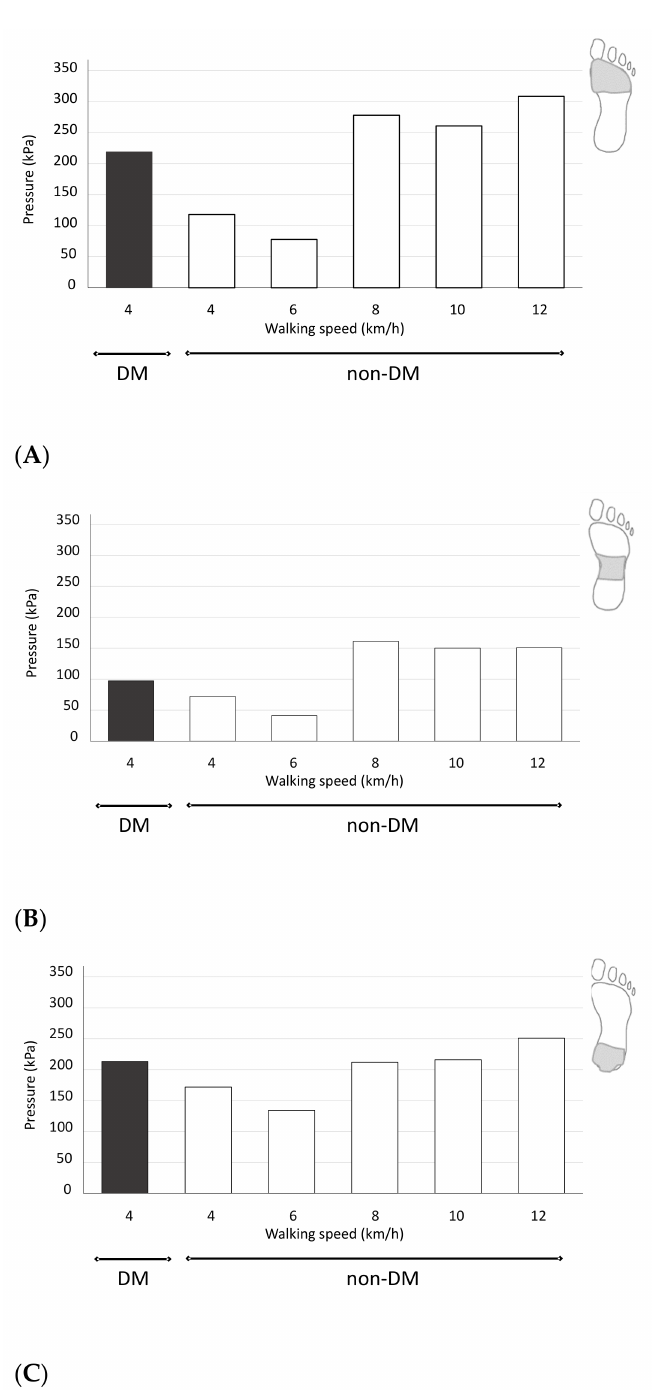
Figure 3. The PPP at three regions ( A ) forefoot, ( B ) midfoot, and ( C ) rearfoot. The speed was categorized as preferred walking speed in people with DM (4 km/h) and five different speeds in non-DM people (4, 6, 8, 10, and 12 km/h, respectively). PPP, peak plantar pressure; DM, diabetes mellitus; non-DM, healthy